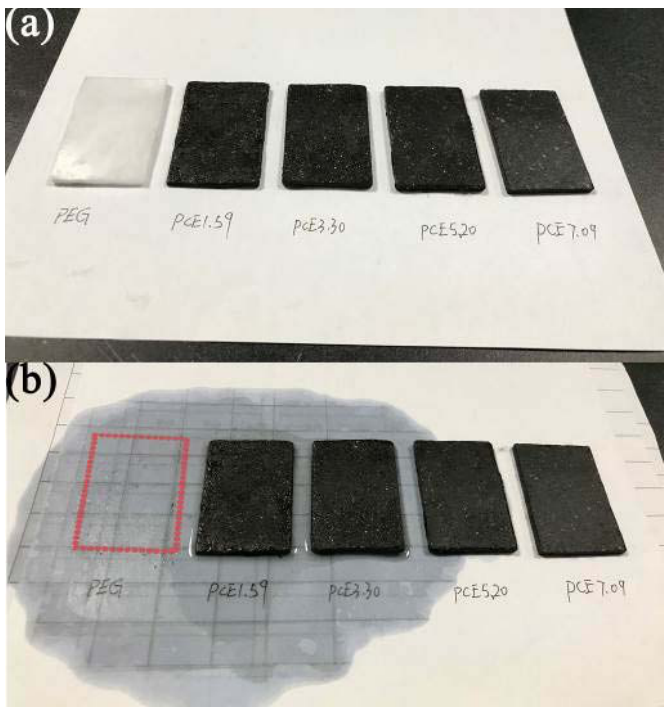
Figure 2. Form stability test of PEG and PCE-CPCMs board (approximately 4.5 3.0 0.2 cm): ( a ) before heat treatment and ( b ) after heating to 70 °C for 1 h.